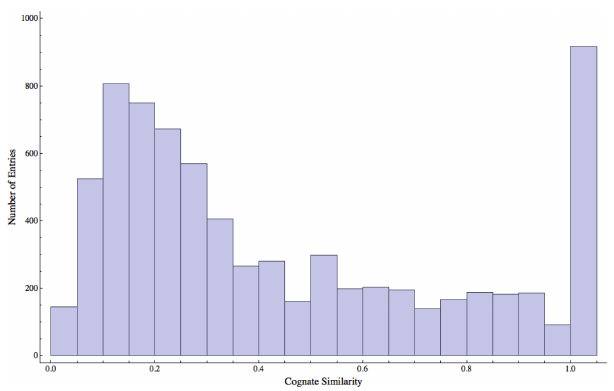
10Show only different PFAM families: The number of top